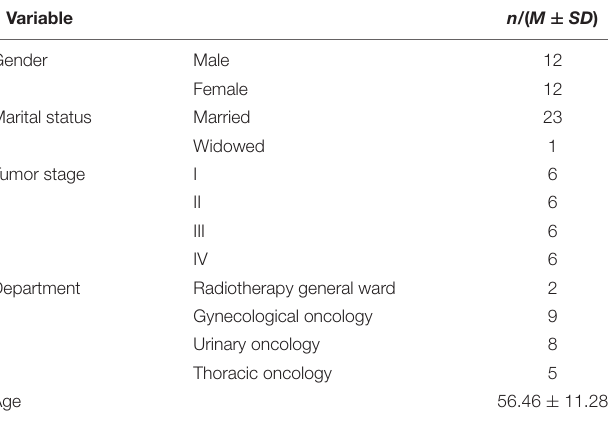
TABLE 1 | Characteristics of participants: open-ended